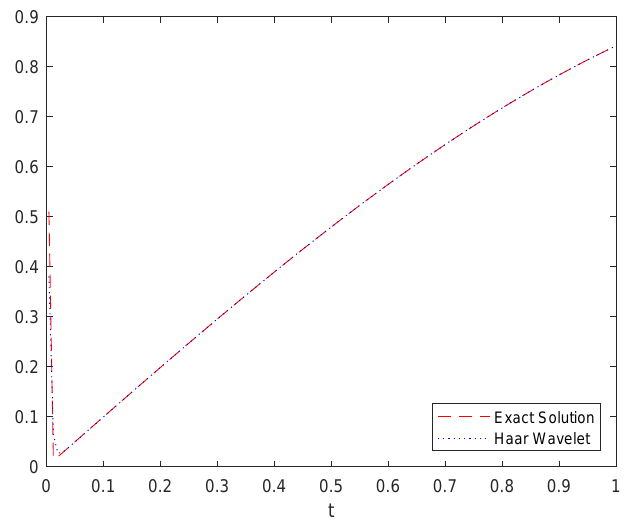
Figure 2. Exact solution and the approximate solutions calculated for J = 6 and i = 128 by Haar Wavelet for Eqn. 8